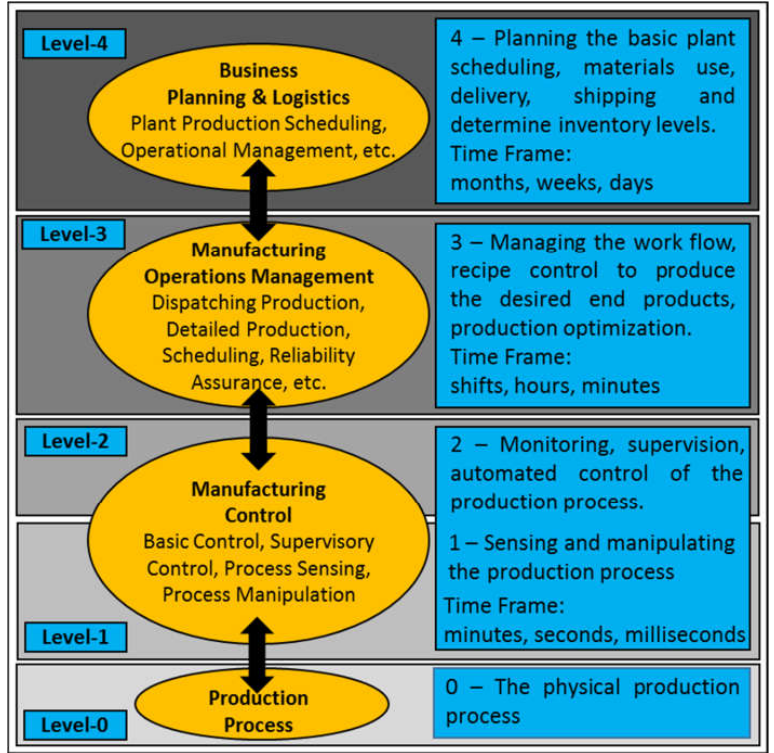
Figure 3. ANSI/ISA-95 Standard Architecture.